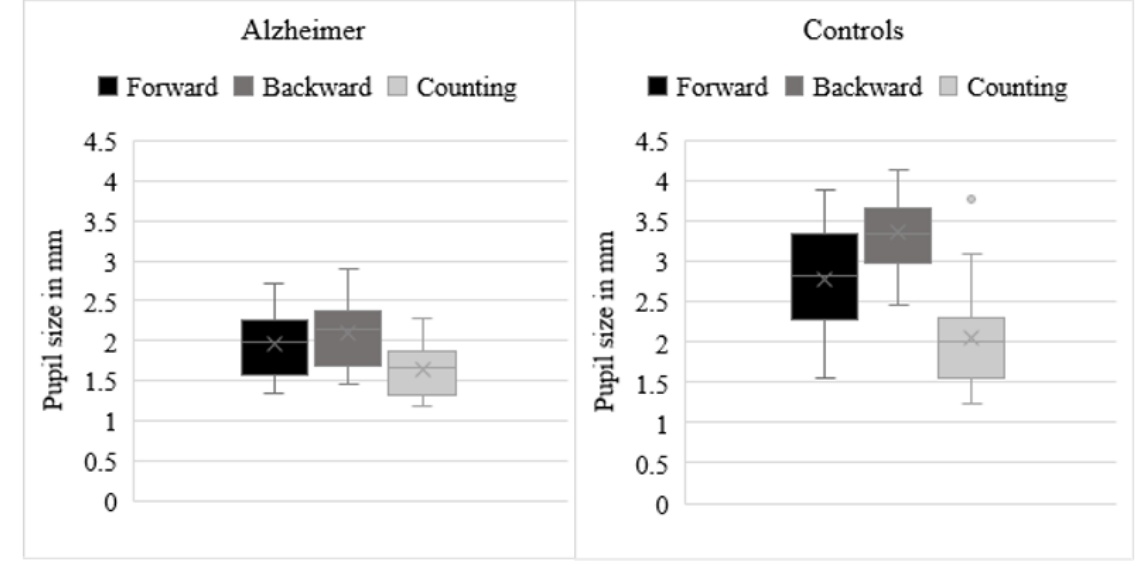
Figure 1: Means of pupil diameters during the forward and backward spans and during the control condition (i.e., counting) in patients with Alzheimer’s disease and control